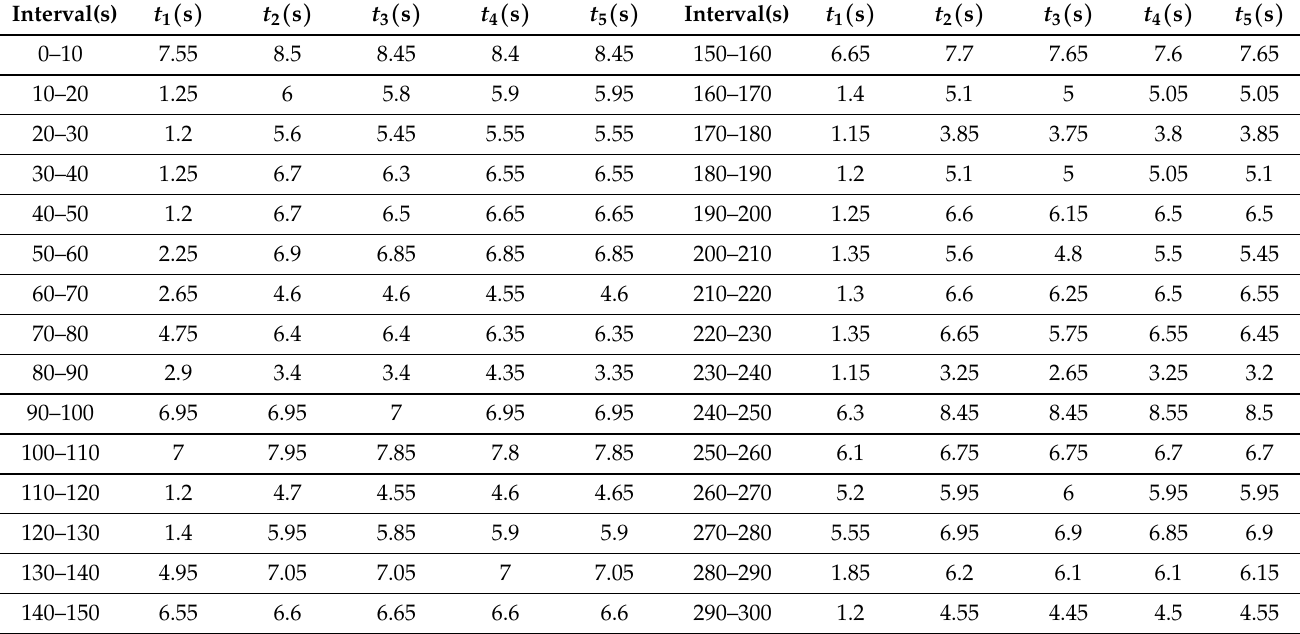
for the different proposed models. opt